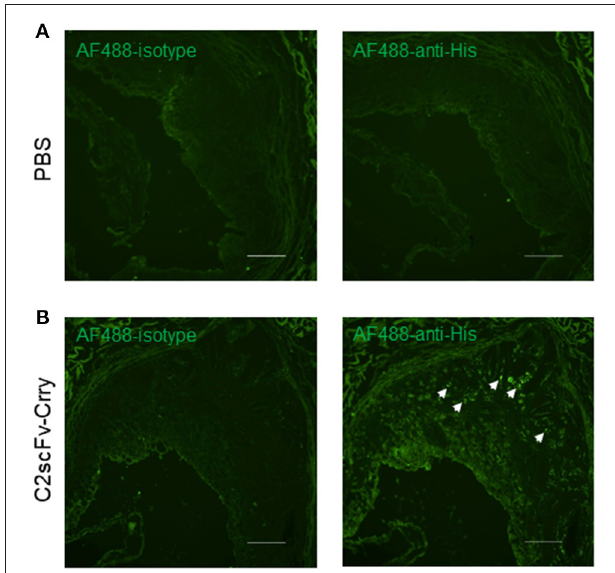
FIGURE 1 | Deposition of C2scFv-Crry in the atherosclerotic plaque of Apoe − / − mice. Aortic root cryosections from Apoe − / − mice treated with PBS (A) or C2scFv-Crry (B) were stained with Alexa Fluor 488 (AF488)-Isotype (left) or anti-His antibody (right). Representative image shows the deposition in the plaque of C2scFv-Crry-treated mice. Scale bar 100